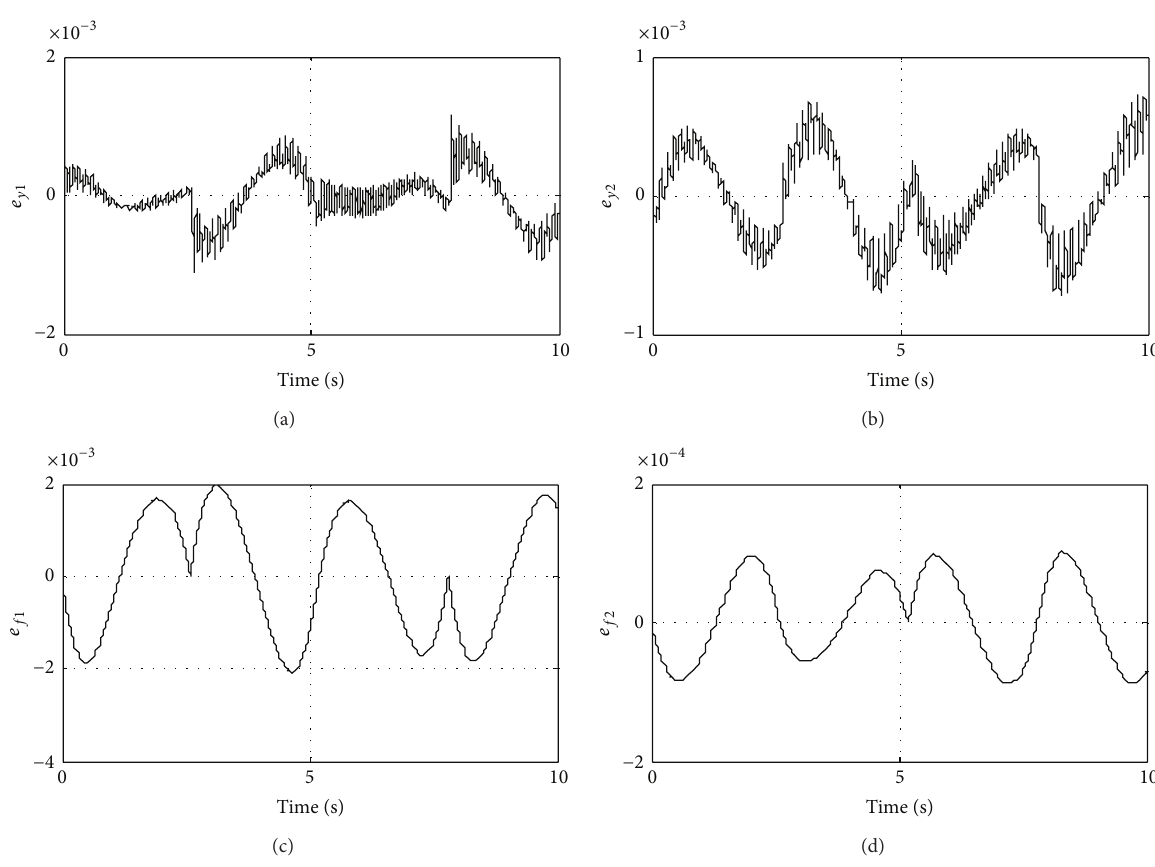
Figure11:Trackingerrorsinjointspace.(a)-(b)trackingerrorsofnoncollocatedoutputsand(c)-(d)trackingerrorsoftheflexiblecoordinates.